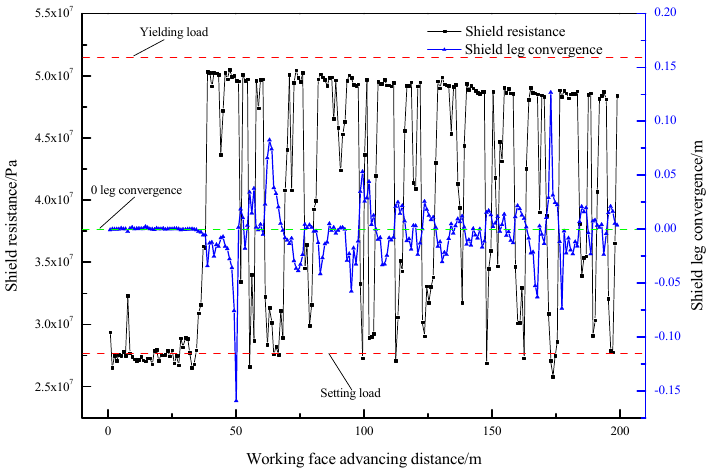
Figure 9. Changes of shield resistance and leg convergence under 5.5 m mining height.